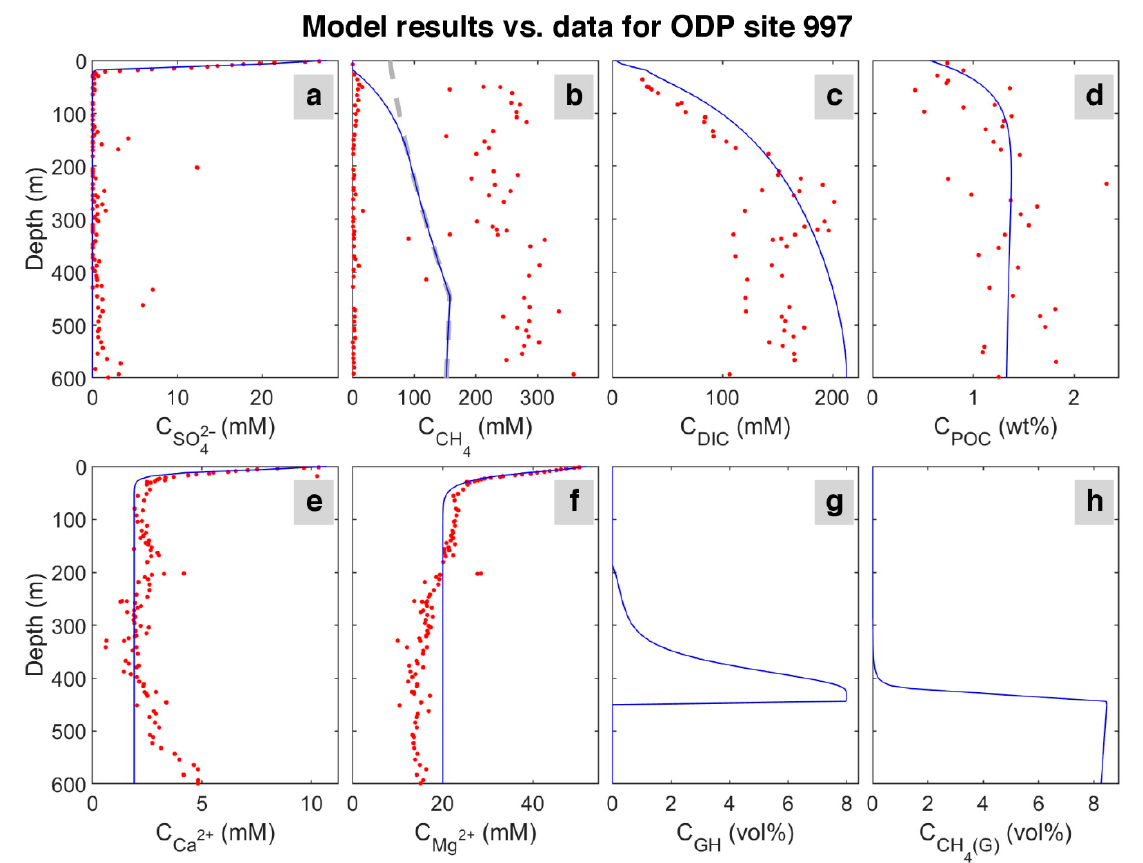
Figure 3. Data for ODP site 997 [49] (circles) and model results (solid lines) in the last time step. The dashed line in the CH 4 concentration profile indicates the saturation of methane with depth. Upper row: concentration of ( a ) sulfate (SO 42 − ); ( b ) dissolved methane (CH 4 ); ( c ) dissolved inorganic carbon (model: DIC = CO 32 − +HCO 3 − +CO 2 and for data: total alkalinity + CO 2 ) in pore water, and ( d ) weight percent of particulate organic carbon (POC) in sediment. Lower row: concentration of ( e ) calcium (Ca 2+ ); ( f ) magnesium (Mg 2+ ) in pore water, and the volume percent (calculated based on the pore volume) of ( g ) hydrate (GH), and ( h ) free gas (CH 4